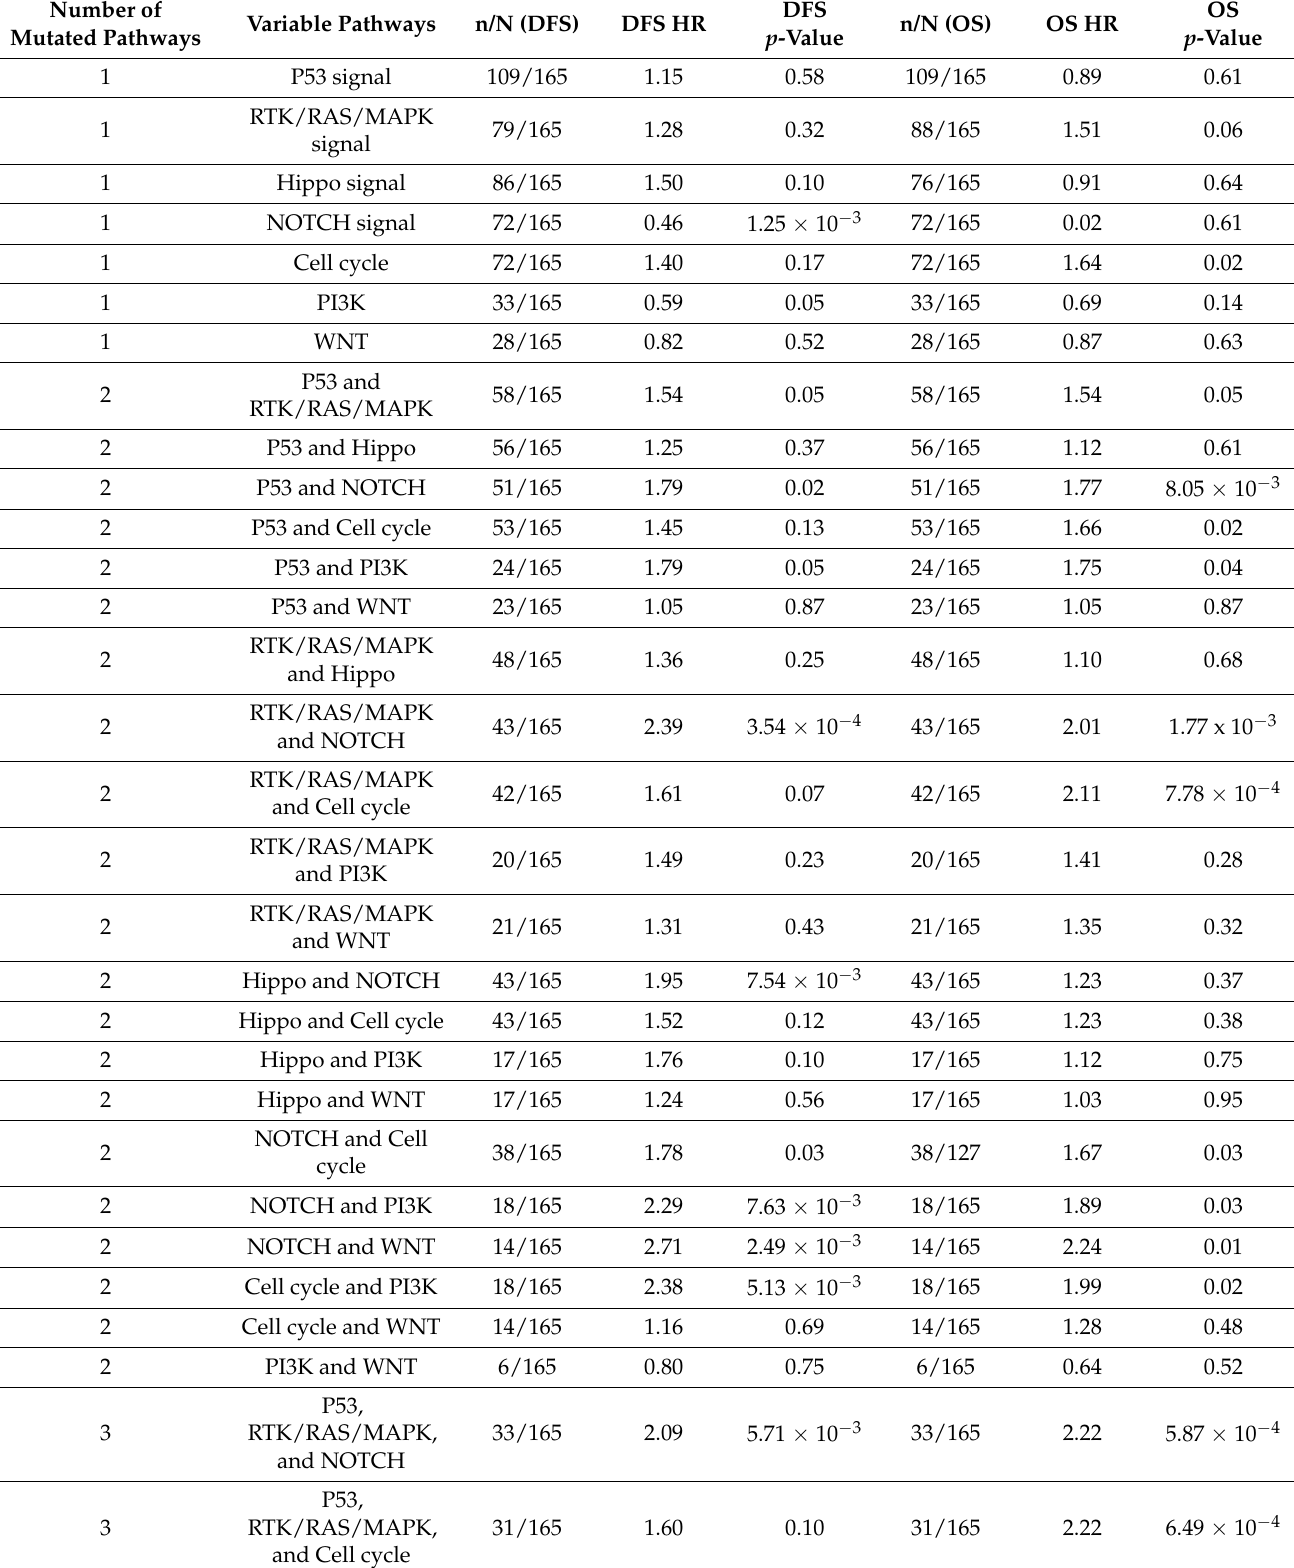
Table 2. Clinical impact of specific pathway mutations on overall survival and disease-free survival in oral cavity squamous cell carcinoma. DFS, disease-free survival; OS, overall survival; HR, hazard ratio. Bold indicated statistically significant findings ( p <